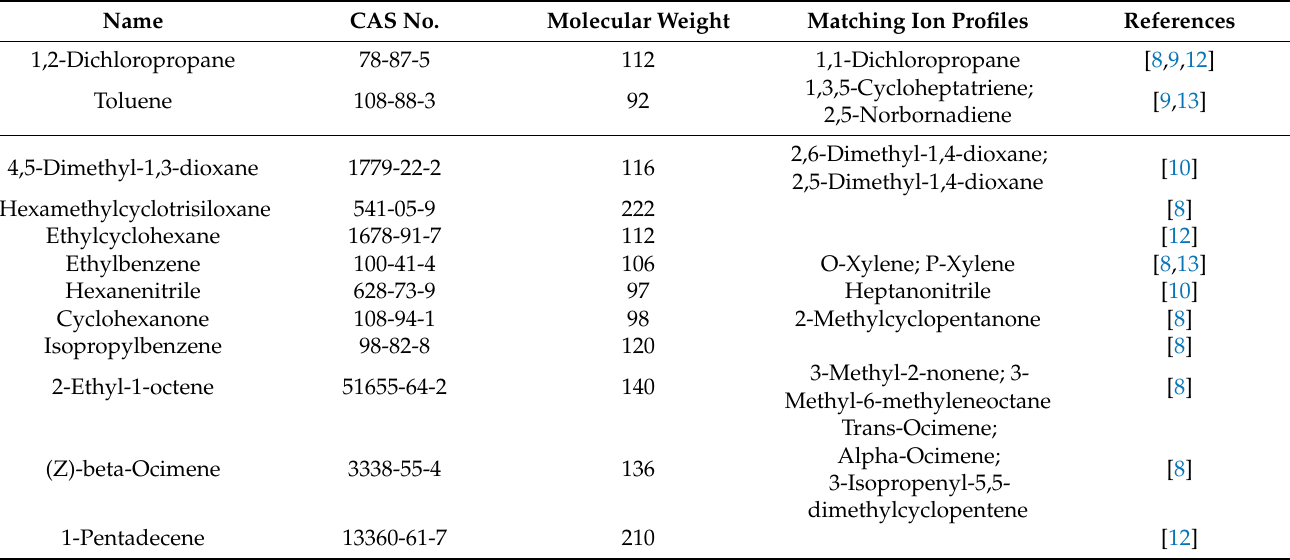
Table 1. Excluded